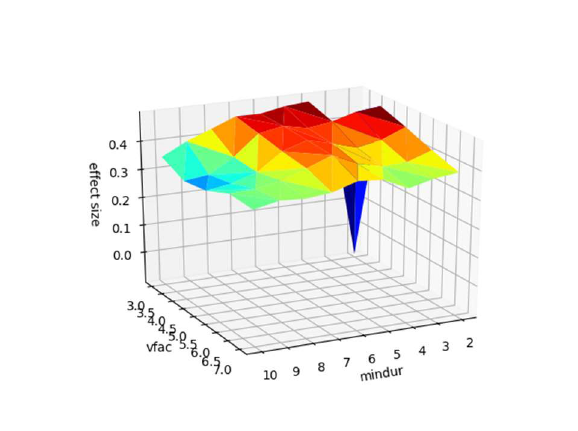
Figure 2: Surface plot of effect size (z-axis) against microsaccade identification parameters (minimum duration, ‘mindur’, x-axis, and velocity threshold scaling factor, ‘vfac’, y-axis). For full description of these parameters see Engbert et al. 2015